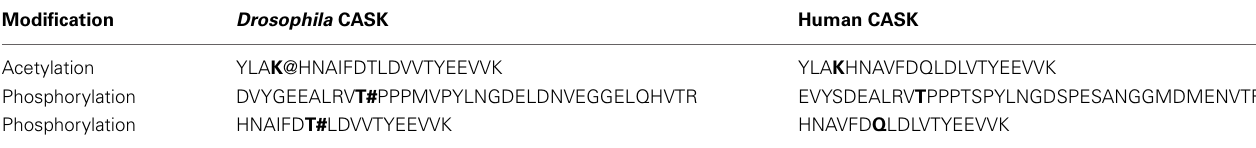
Table 3 | Posttranslational modification of